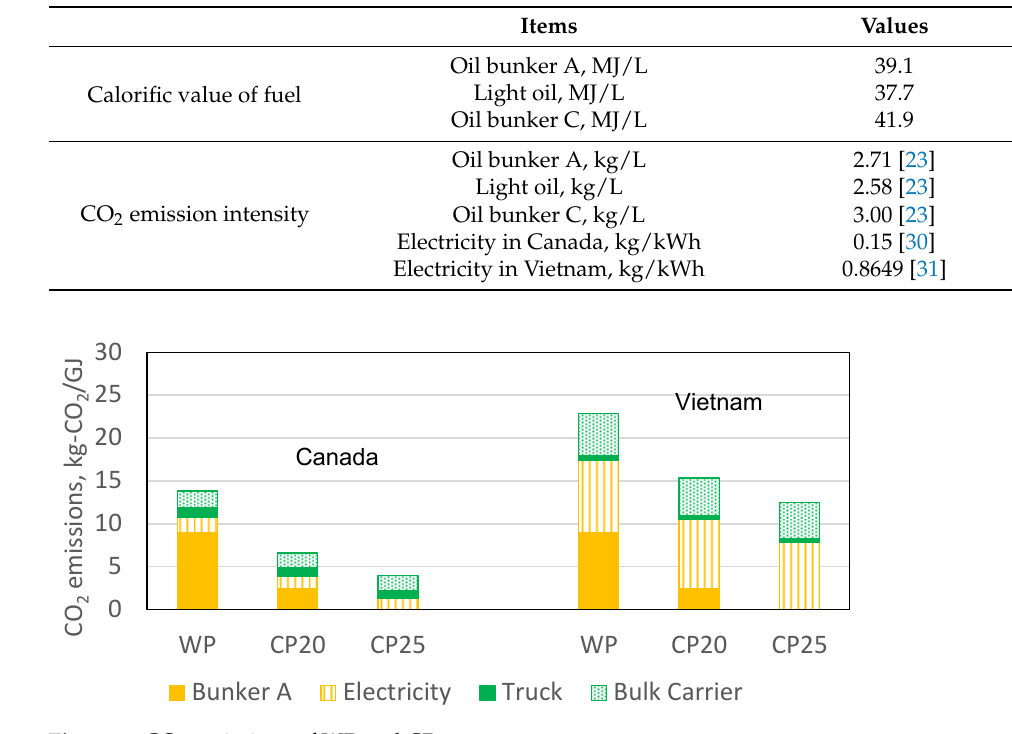
Table 6. Calorific value of fuel and CO 2 emission intensity.